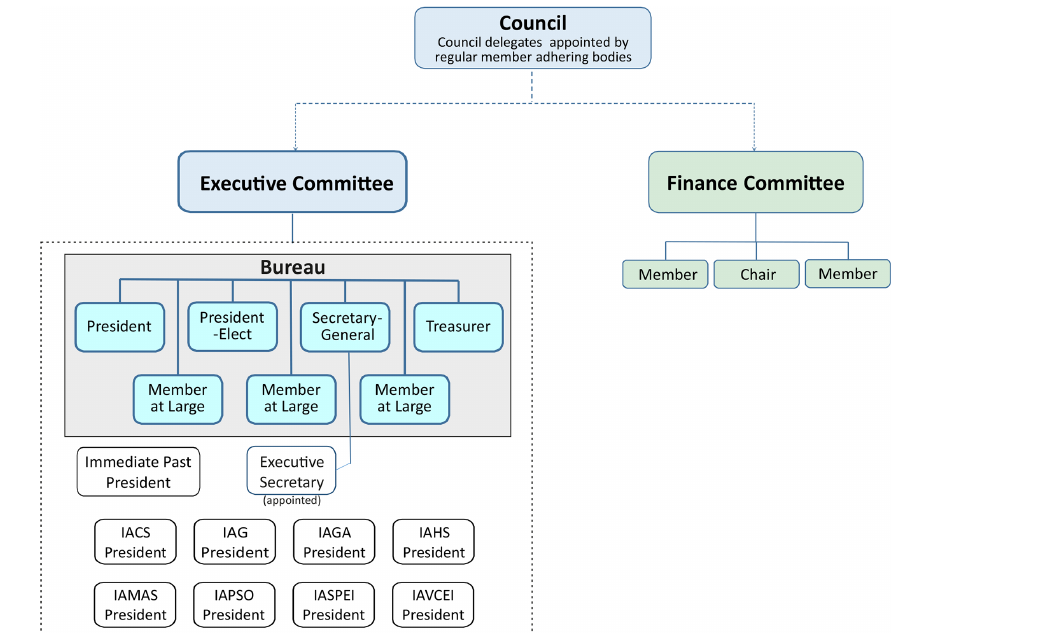
Figure 1. The IUGG governance (designed by F.